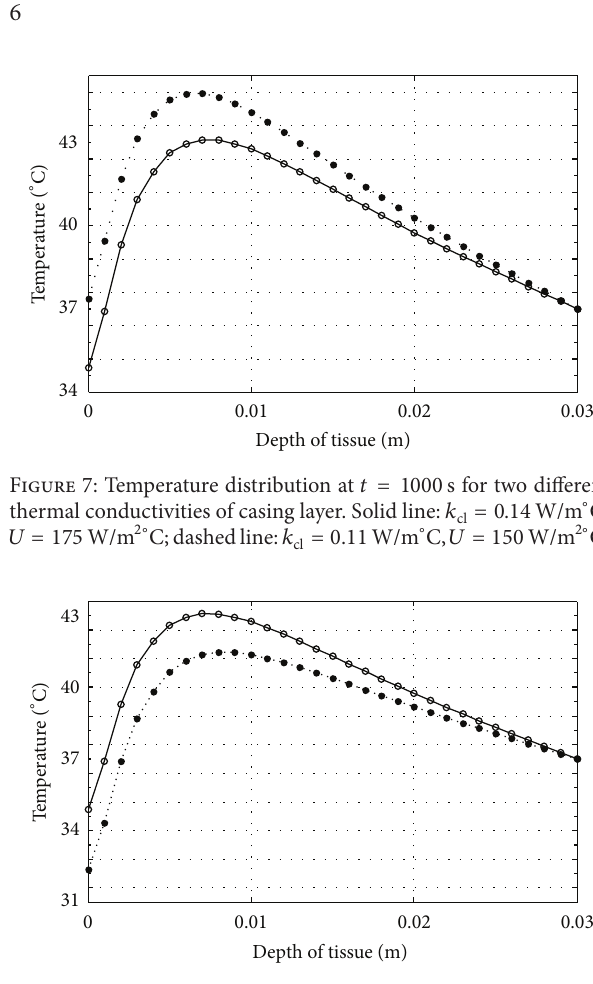
Figure 8: Temperature distribution at 𝑡 = 1000 s for two different heat convection coefficients of water. Solid line: ℎ = 200 W/m 2∘ C, 𝑈 = 175 W/m 2∘ C; dashed line: ℎ = 350 W/m 2∘ C, 𝑈 = 200 W/m 2∘